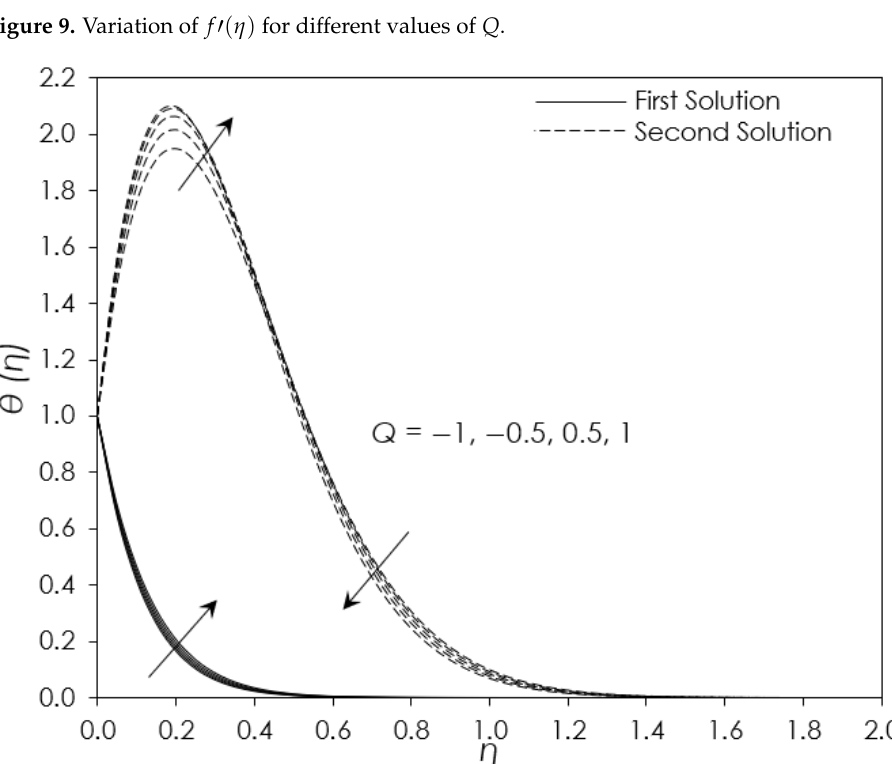
Figure 10. Variation of 𝜃(𝜂) for different values of 𝑄 .